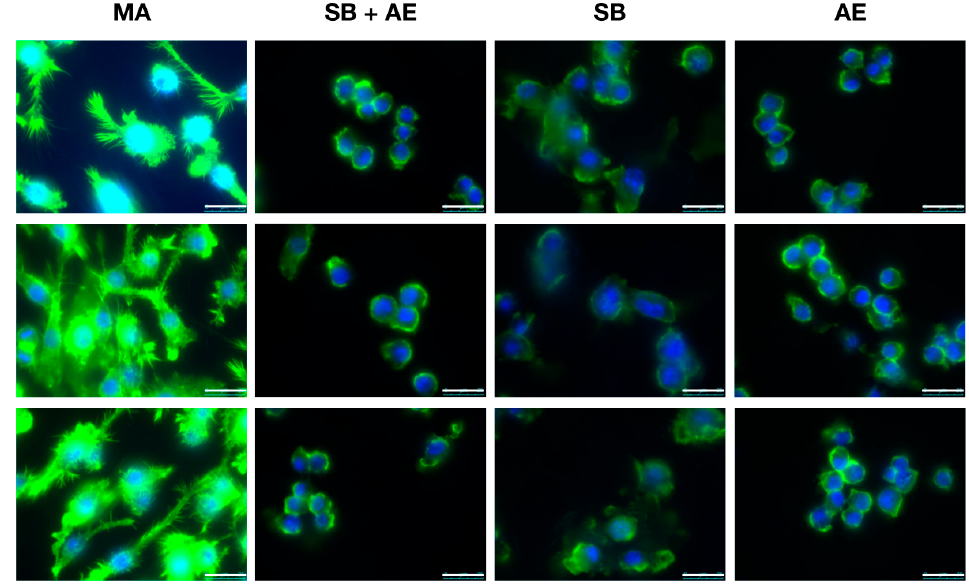
Figure 4. Cell morphology of RAW 264.7 cells cultured over the different Ti-discs by fluorescence microscopy. Surface treatment: mechanical abrasion (MA), sandblasting plus etching (SB + AE), sandblasting (SB) and acid etching (AE). In blue, nuclei with DAPI; in green, actin filaments with phalloidin 488. Scale bar: 25 µm. (n = 3).